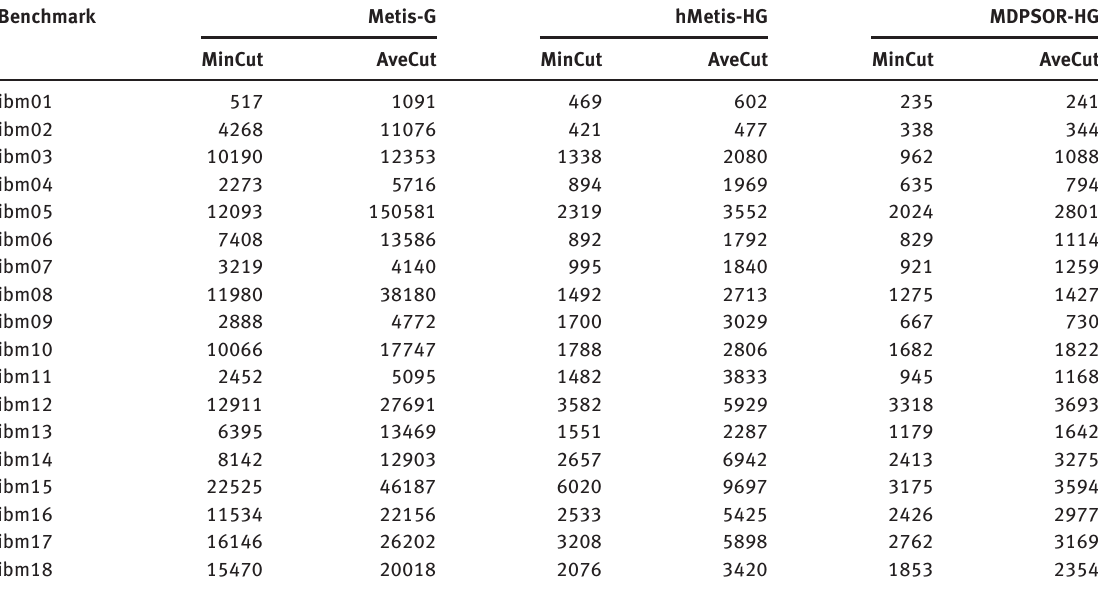
Table 2: The Experiment Comparison of the Min-cut Bipartitioning Results with up to 2% Deviation from Exact Bisection among Metis-FM -Graph, hMetis-FM -HyperGraph, and UMpack -MDPSOR – H yper G